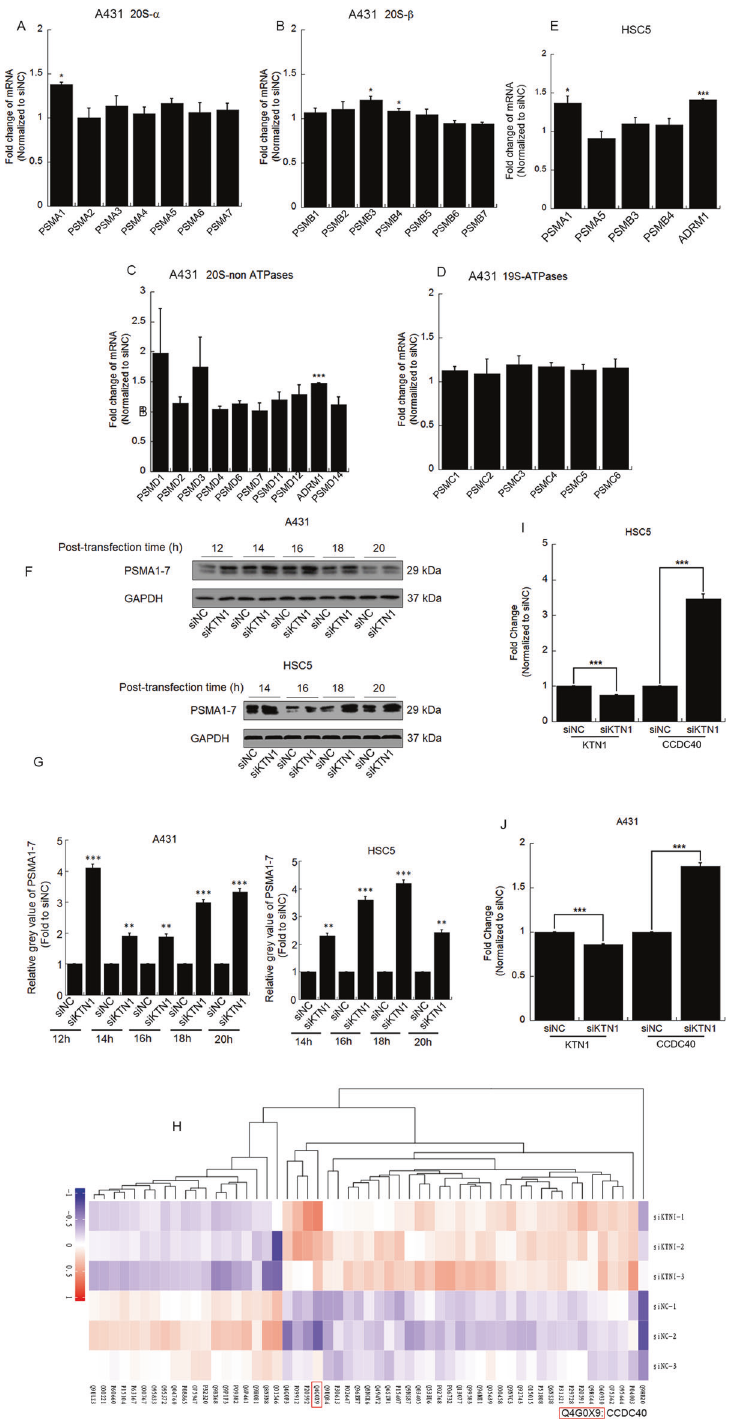
Fig. 3 CCDC40, PSMA1, and ADRM1 are upregulated by knockdown of KTN1 . A – D A431 cells were transfected with siKTN1. Total RNA was extracted, and mRNA of all proteasome subunits was detected by qRT-PCR. qRT-PCR results represent the means ± SD. Representative of results from three biological replicates. E HSC-5 cells were transfected with siKTN1. Total RNA was extracted, and PSMA1, PSMA5, PSMB3, PSMB4, and ADRM1 mRNAs were detected by qRT-PCR. qRT-PCR results represent the means ± SD. Representative of results from three biological replicates. F A431 or HSC-5 cells were transfected with siKTN1. Total cell lysates were collected at the indicated times and subjected to Western blotting. Representative of results from three biological replicates. G Gray value was analyzed by Image J. Representative of results from 3 biological replicates. H Differentially expressed proteins were clustered and shown in a heat map by hierarchical clustering analysis for proteomic pro fi les extracted from iTRAQ markers. The normalized log 2 of the fold change is represented in the heatmap by different colors. The maximum value is normalized to 1, and the minimum value is normalized to – 1 to indicate the expression pro fi les of differential proteins under different experimental conditions. Representative of results from three biological replicates. I , J A431 or HSC-5 cells were transfected with siKTN1. Total RNAs were extracted, and CCDC40 mRNA was detected by qRT-PCR. qRT-PCR results represent the means ± SD. Representative of results from three biological